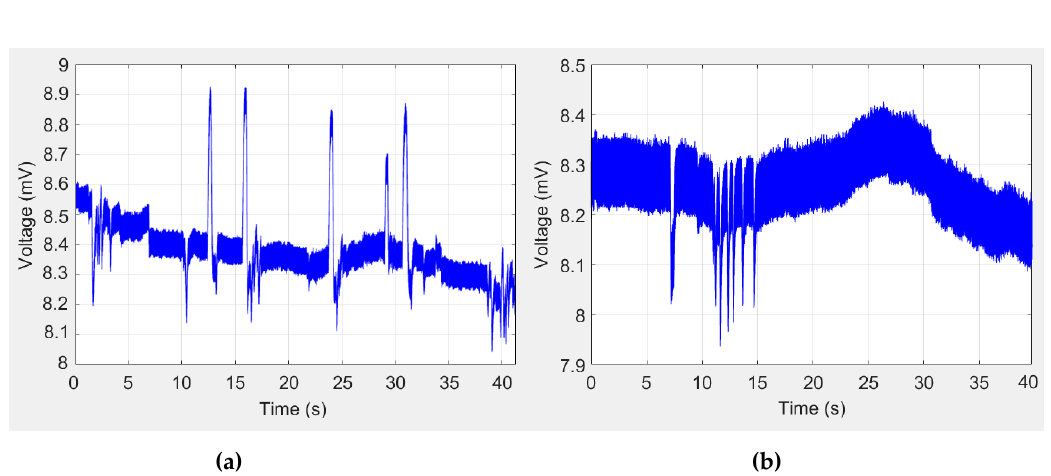
Figure 5. Examples of EOG signals before being digitally processed in the computer: ( a ) signal in which the peaks of the saccades stand out on the SEM of tracking and fixation; ( b ) signal in which only fixation micromovements are